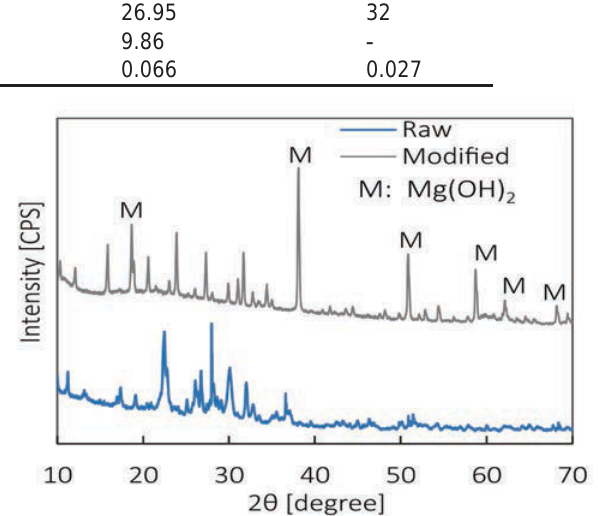
Fig. 4. The XRD pattern of raw and modified TUSH-ZEO Table 3. Elemental analysis of the natural minerals with modification of Elements